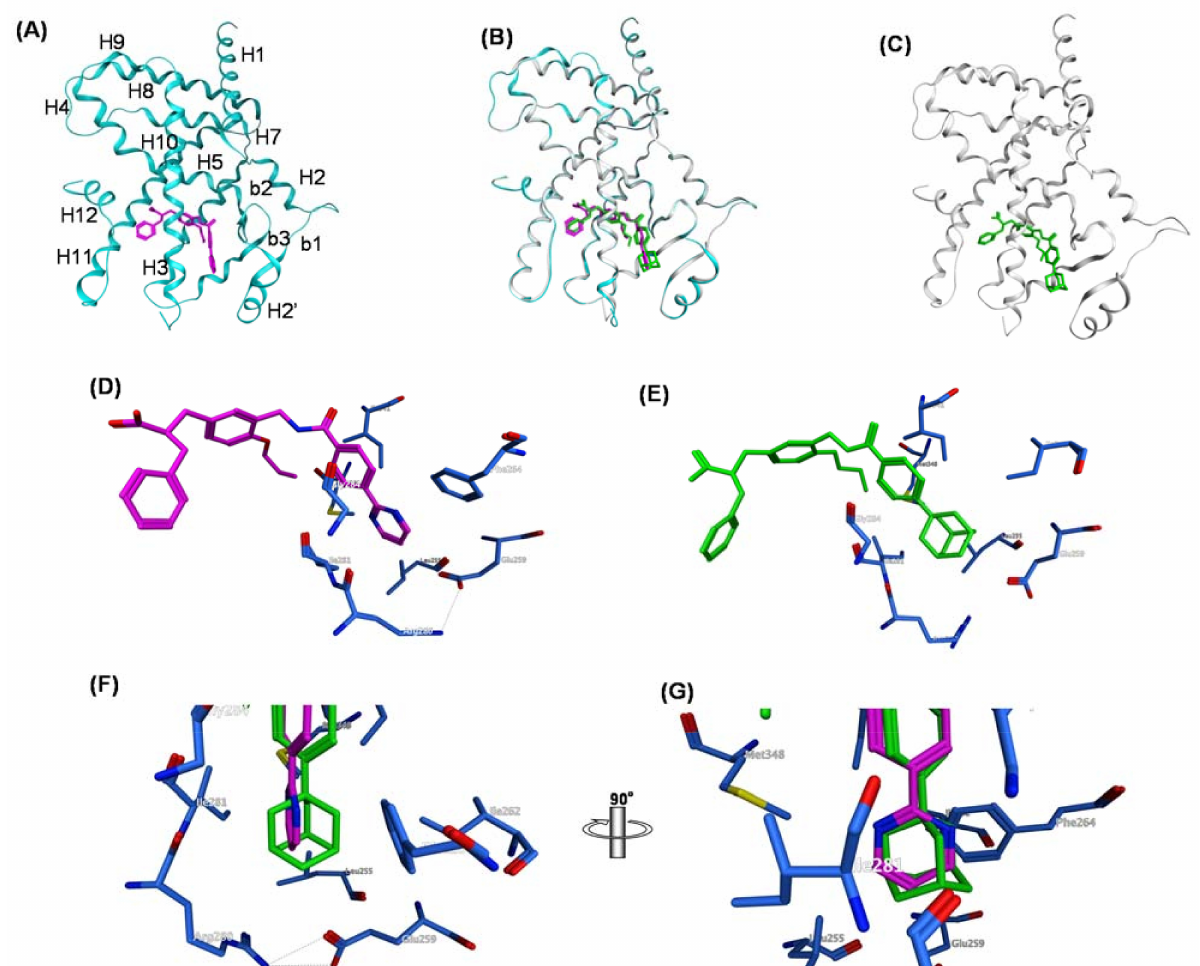
Figure 19. ( A – G ) Crystal structures of hPPARc LBD–MO-4R and hPPARc LBD–MEKT-21 complexes. ( A ) Structure of the whole hPPARcLBD–MEKT-21 complex. Protein is represented by a blue ribbon model and MEKT-21 is depicted with a magenta cylinder model. The numbering of the second structure is also depicted. The nomenclature of the helices is based on the RXR- α crystal structure. ( B ) The superimposed structures of MO-4R and MEKT-21 complexed with the hPPARc LBD. ( C ) Structure of the whole hPPAR χ LBD–MO-4R complex. Protein is represented by a white ribbon model and MO-4R is depicted with a green cylinder model. ( D ) Zoomed view of the binding mode of the hydrophobic tail part of MO-4R in the Y3 arm. The side chains of amino acids of the Y3 arm are depicted by blue cylinder models. ( E ) Zoomed view of the binding mode of the hydrophobic tail of MEKT-21 in the Y3 arm. ( F ) Zoomed view of the alignment of the hydrophobic tail of MO-4R and MEKT-21. ( G ) Image F rotated by 90